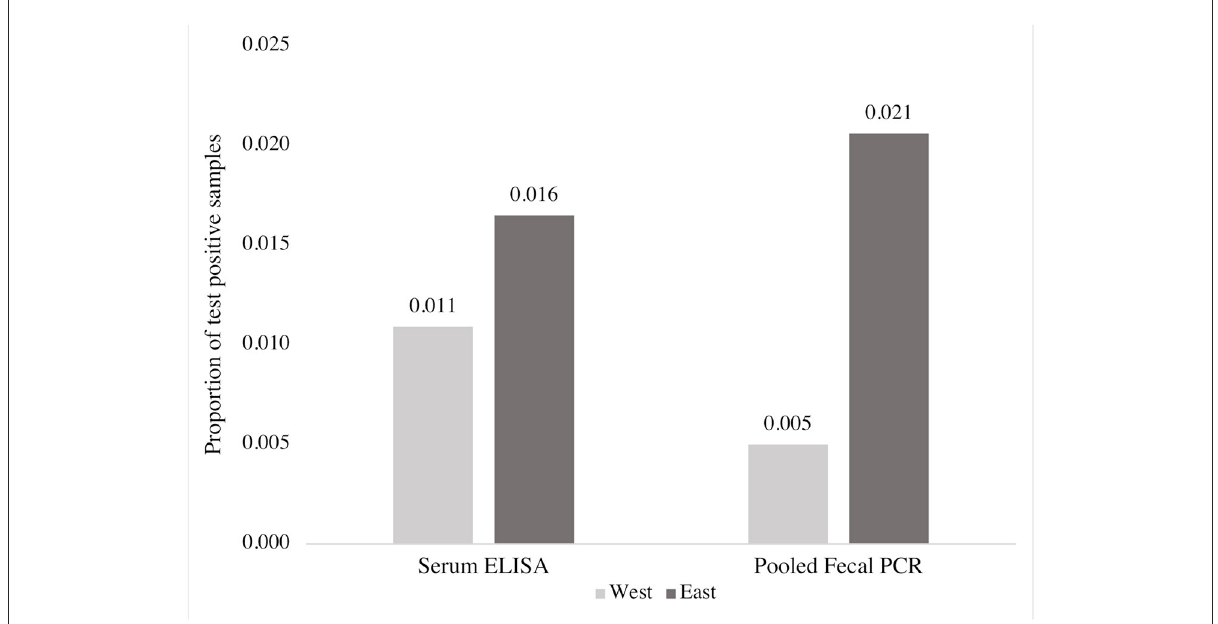
FIGURE2 Comparison of the proportion of MAP positive blood and fecal samples detected by ELISA and fecal PCR (pools of five fecal samples), respectively, from 3,171 beef cows according to region.